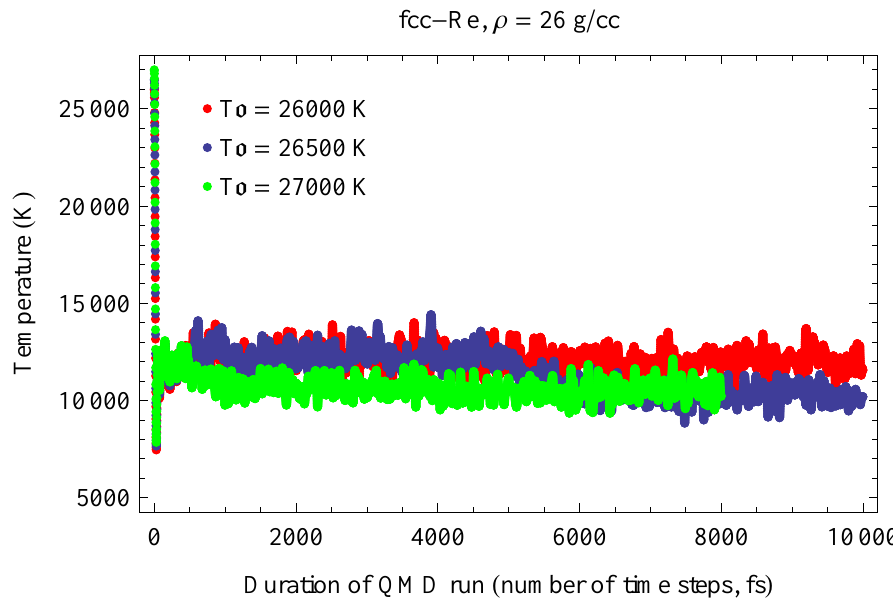
Figure 5. The same as in Figure 4 for the time evolution of P . During melting P increases from 210 GPa for the superheated state to 217 GPa for the liquid at the corresponding melting point. ∼ ∼ ∼